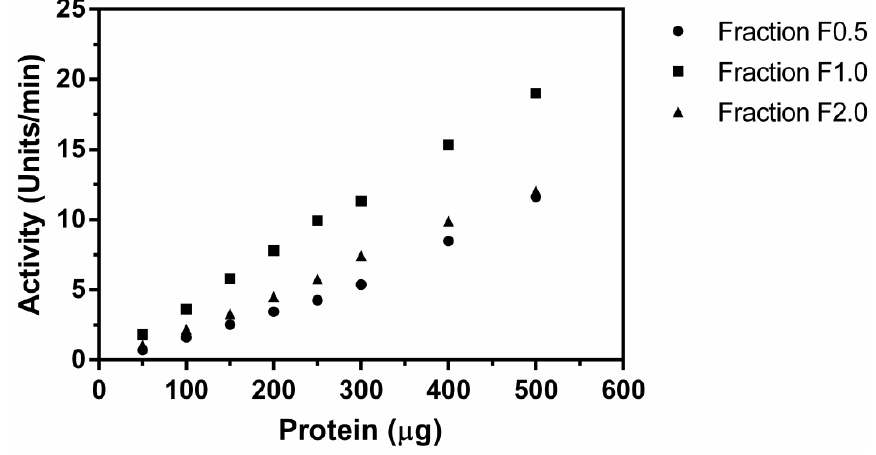
Figure 1. Azocaseinolytic activity of C. urens fractions F0.5, F1.0 and F2.0 . Reaction mixture (350 µL) contained 100 µL of azocasein (1%) in 0.05 M Tris-HCl, 0.15 M NaCl, pH 7.5 incubated with different concentrations of C. urens fractions ranging from 50–500 µg for 30 min at 37 °C. Values represent mean ± SEM ( n =